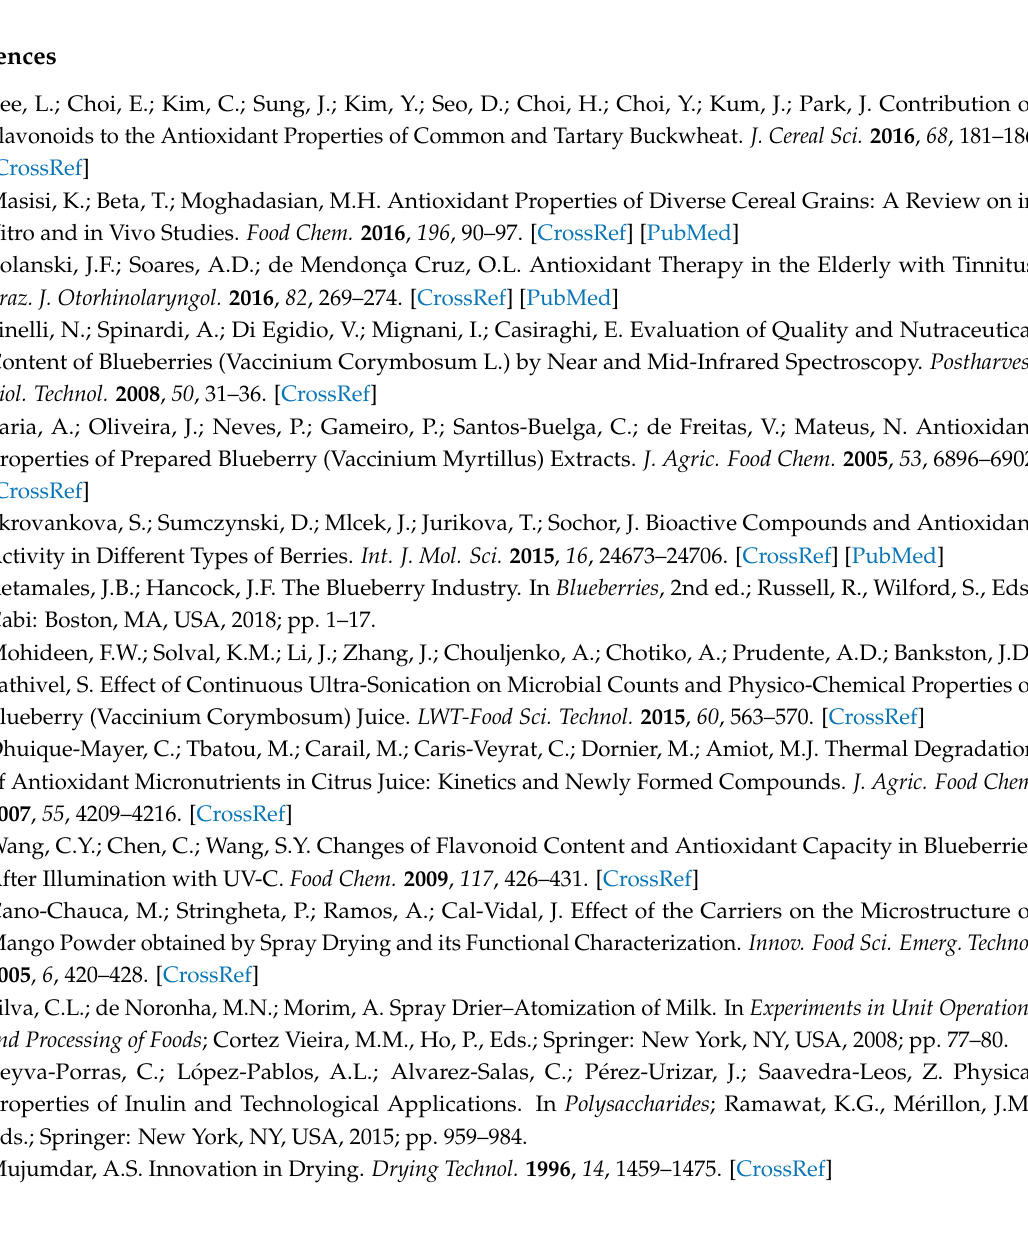
Figure S1: Thermal analysis of selected BJ-MX samples: (A) TGA and (B) DSC; Figure S2: Chromatograms obtained for the calibration curve of quercetin 3-D-galactoside at five concentrations (0.1, 1, 5, 10, and 20 µ g/mL). Figure S3: Calibration curves for quercetin 3-D-galactoside. Figure S4: Typical chromatogram of an injected dry powder (experiment 18) after the extraction process. Table S1: Experimental data obtained for each calibration